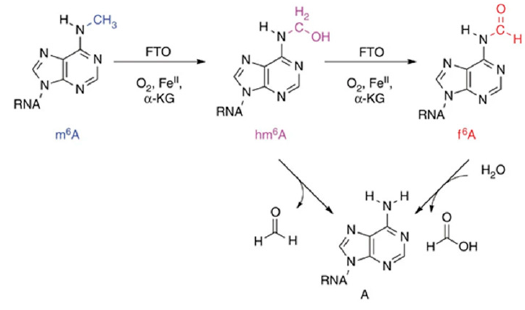
Figure 2. Mechanism of action of demethylase FTO [28] .